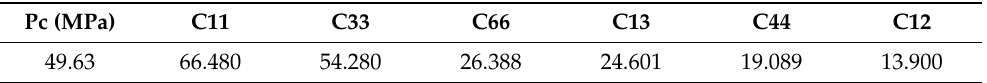
Table A2. Cotton Valley shale elastic moduli from Tosaya (1982). Stiffnesses are in GPa. Pc (MPa) C11 C33 C66